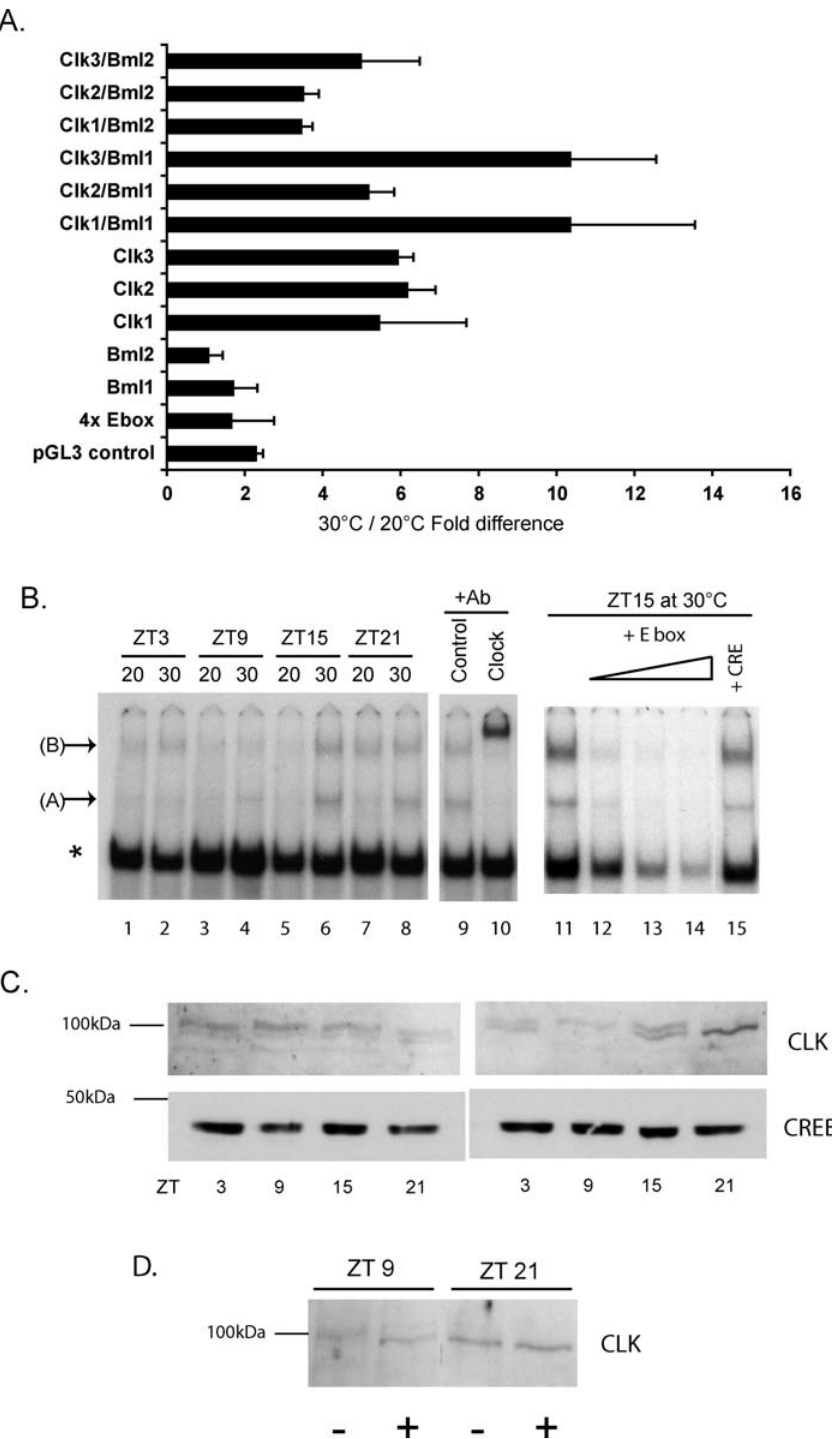
Figure 6. Temperature Influences CLK Protein Expression and Function (A) In vitro luciferase assays of transiently transfected PAC2 cells. The combinations of CLK (Clk) and BMAL (Bml) expression vectors cotransfected with the 4x Ebox ( (cid:1) 7) reporter plasmid are indicated for each assay result. Control cells were transfected with the reporter plasmid or with the pGL3 Control plasmid alone. Values represent the mean fold difference between luciferase activities measured in 30 8 C and 20 8 C, 60 h after transfection. All assays were standardized for transfection efficiency using a b -galactosidase assay. The results are based on four independent experiments, and error bars indicate the standard deviation. (B) Electrophoretic mobility shift assay of nuclear extracts from PAC-2 cells cultured at 20 8 C or 30 8 C on a LD cycle, and harvested at ZT3, 9, 15, and 21 (lanes 1 to 8). Three specific complexes are indicated by A, B, and an asterisk. Supershift assays of a ZT15, 30 8 C extract ( þ Ab), used either a dopamine transporter antibody (Control) or a mouse clk antibody (Clock) (lanes 9 and 10). Complexes indicated by A, B, and an asterisk are all efficiently competed by a 25-, 50-, and 100-fold excess of cold E-box probe (lanes 12, 13, and 14, respectively, and compare with lane 11), but not with a 100-fold excess of a CRE probe (compare lane 15 with lane